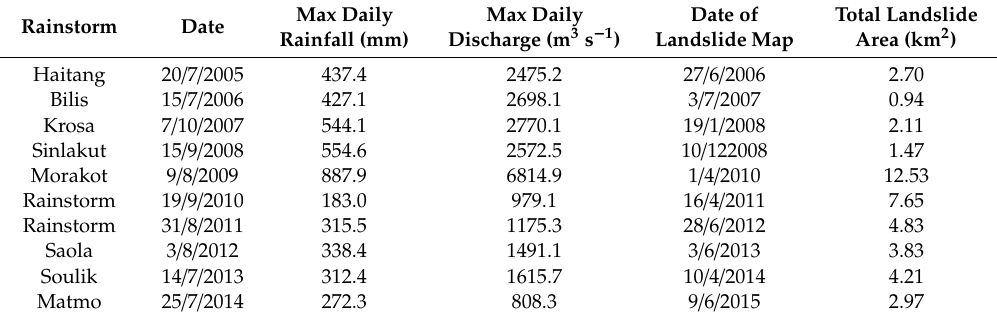
Table 1. Basic information for the observed total landslide area and their triggers, i.e., typhoons or